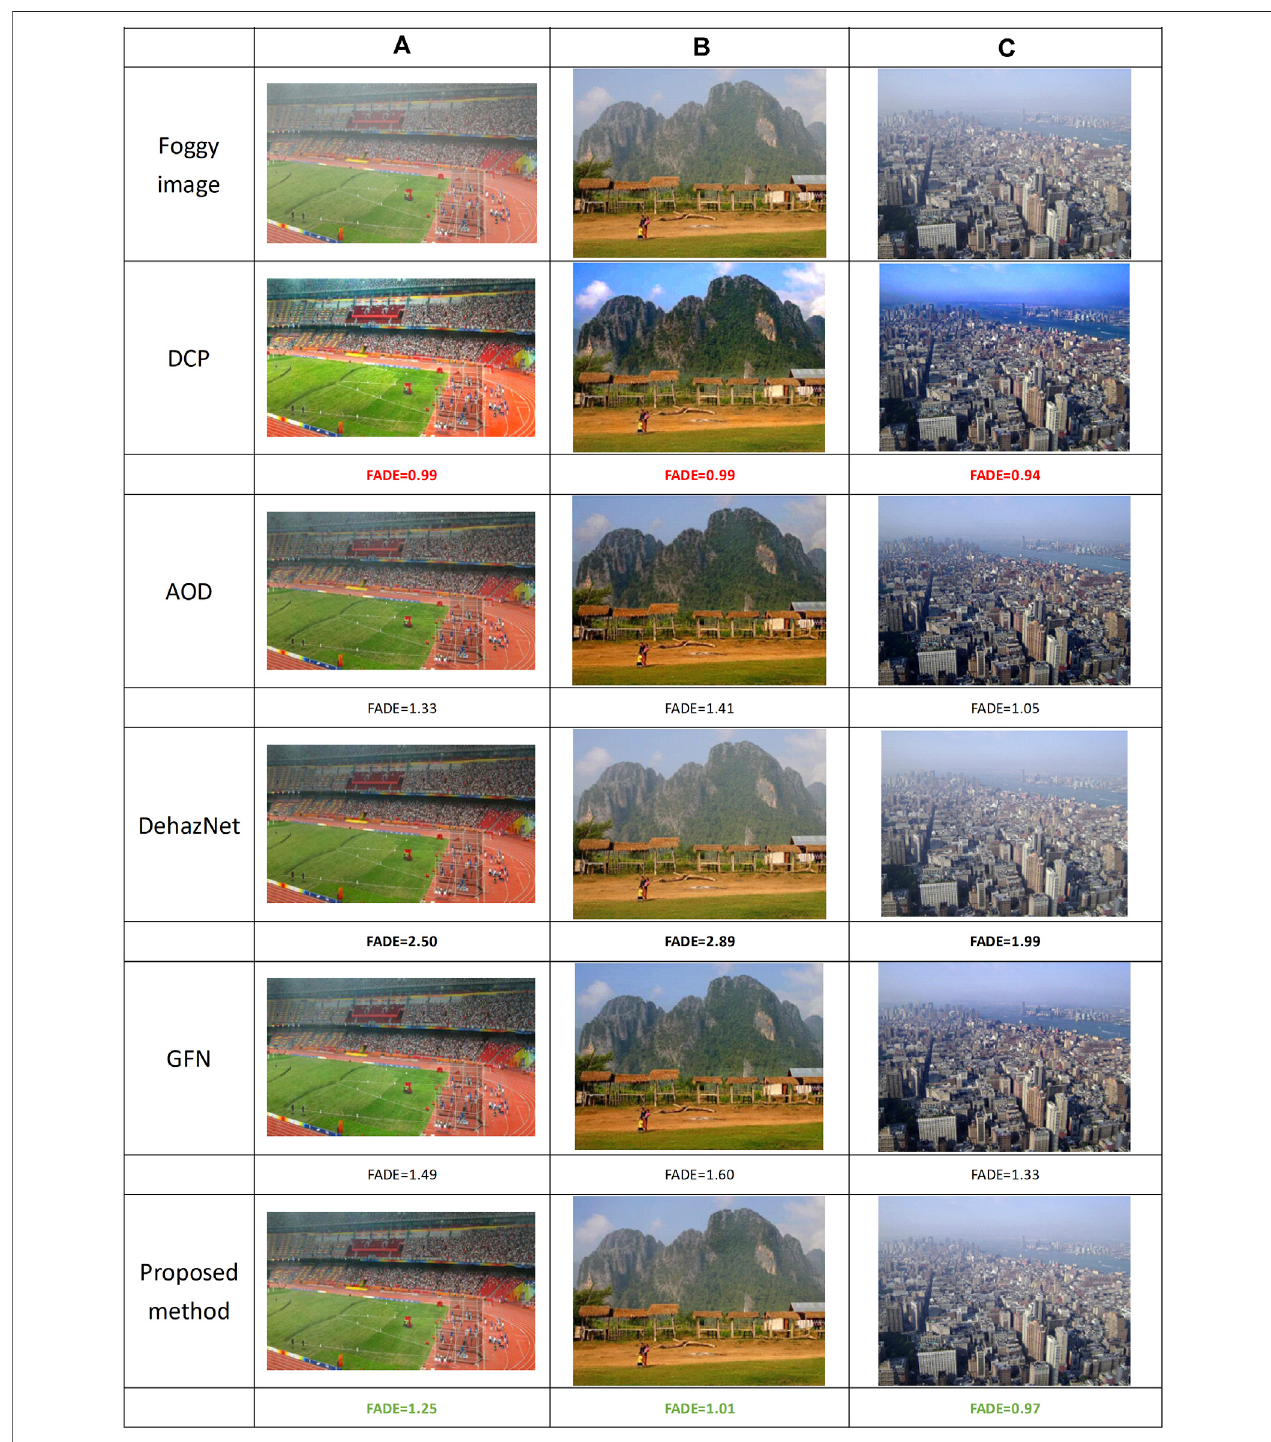
FIGURE 6 | Some dehazing images and their image quality metrics of real foggy data in SOATS and on the Internet.